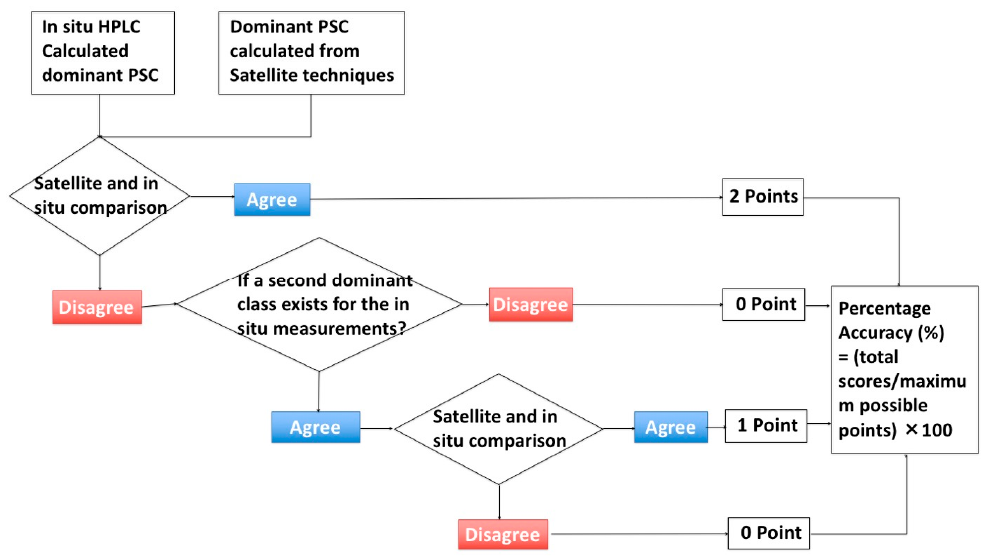
Figure 4. Flow chart of the evaluation method.